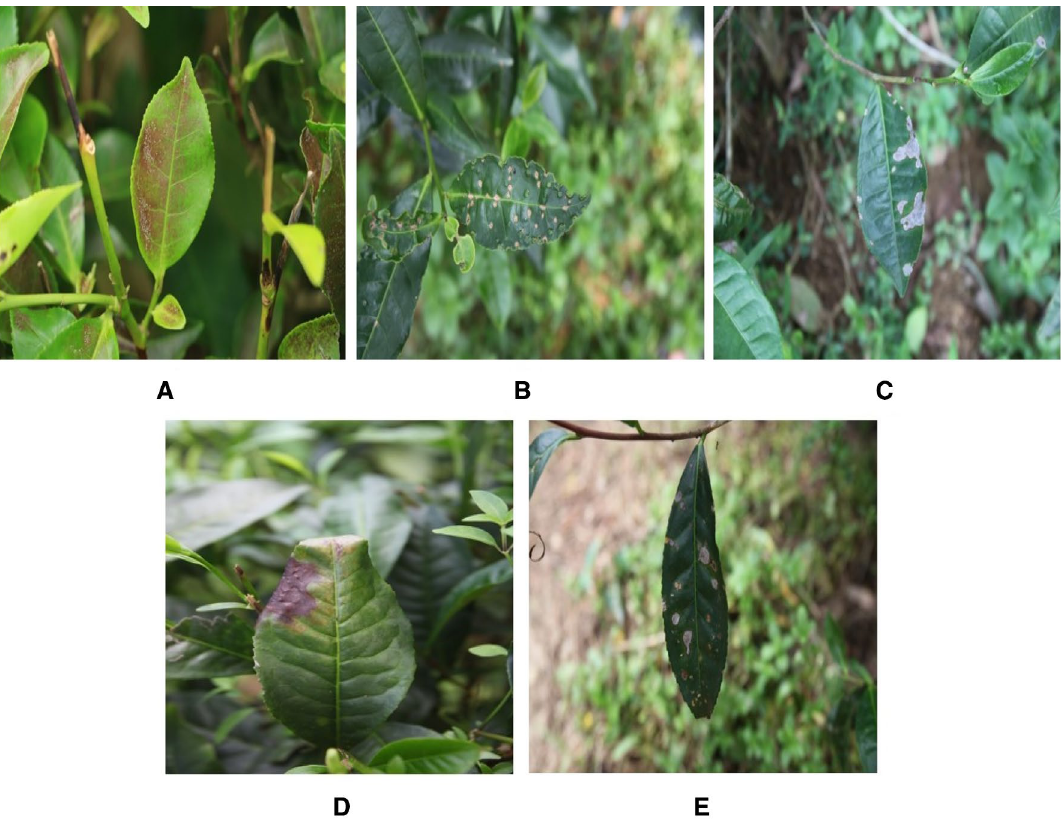
Figure 3. Images of tea leaf diseases: ( a ) red spider, ( b ) tea mosquito bug, ( c ) black rot, ( d ) brown blight, ( e ) leaf